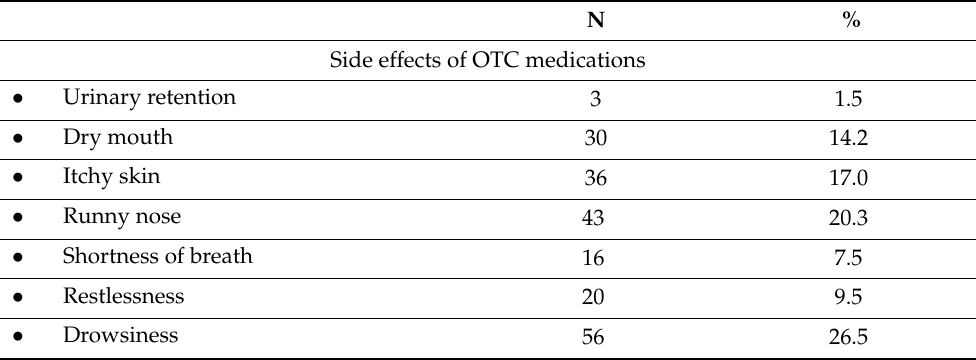
Table 3. Side effects of OTC medications and parents’ response when side effects of OTC medications appear in their children.